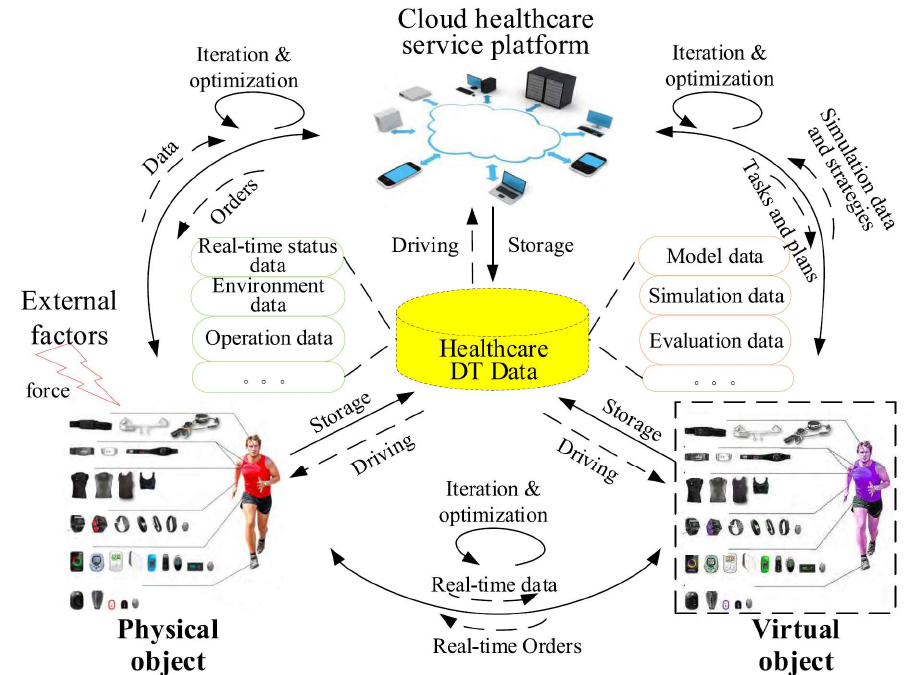
Figure 7. Framework for DT used in healthcare: data are acquired in real time from wearable sensors, and sent to models for simulation and evaluation. The historical records are recorded in the cloud to provide personalized healthcare services